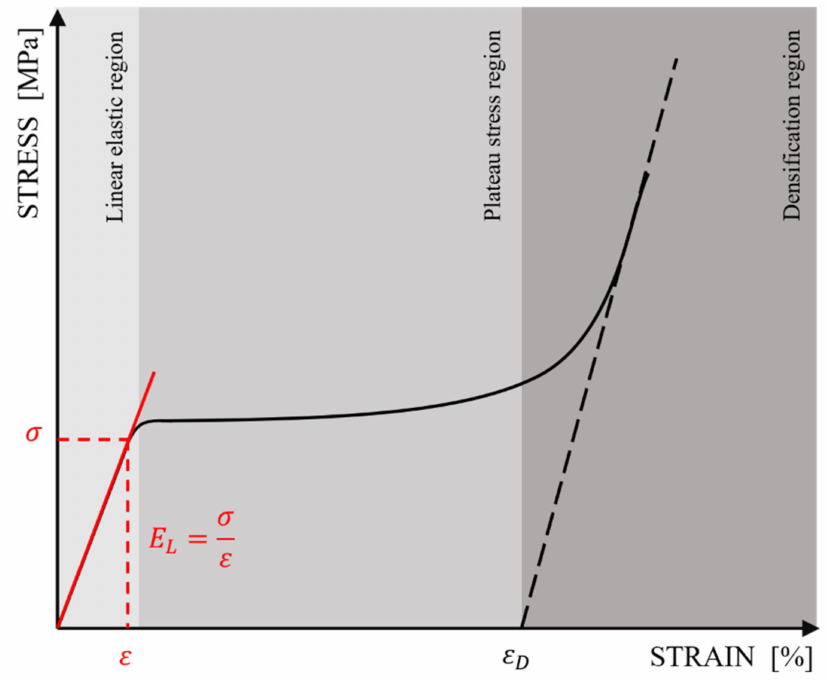
Figure 1. Theoretical compressive stress–strain curve for the cellular structure of plastic